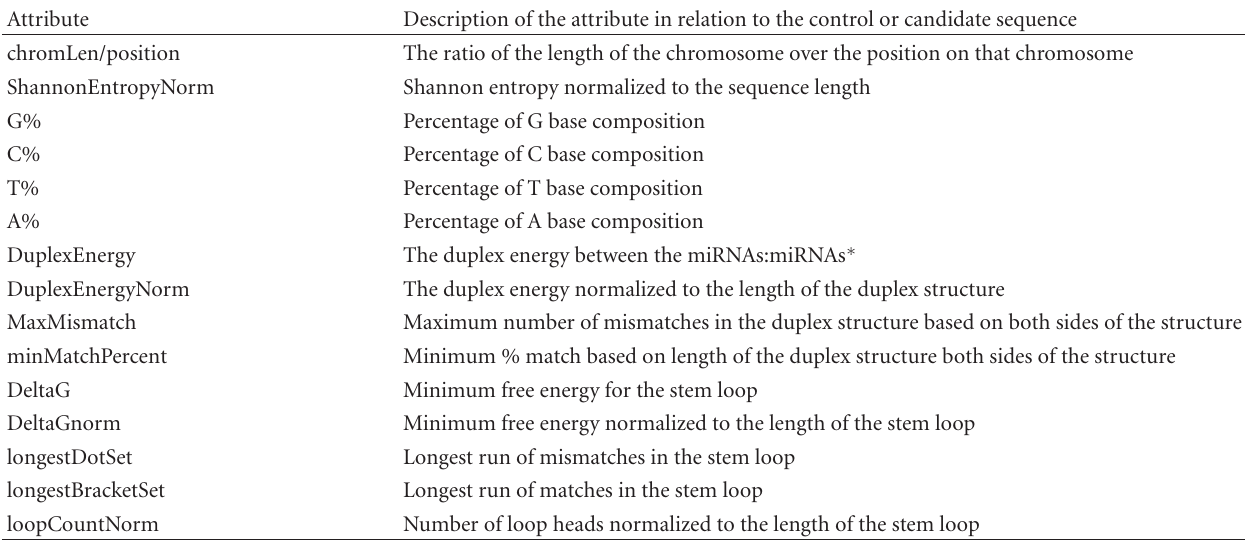
Table 3: Base set of